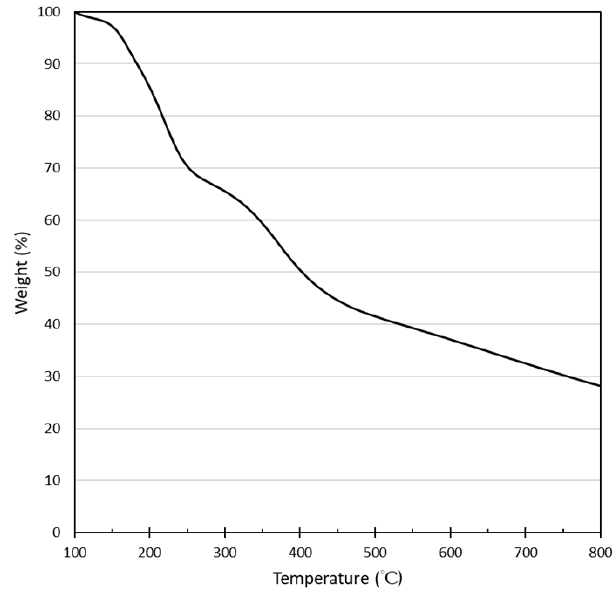
Figure 9. Crystallinity index of CNCs prepared in different conditions.